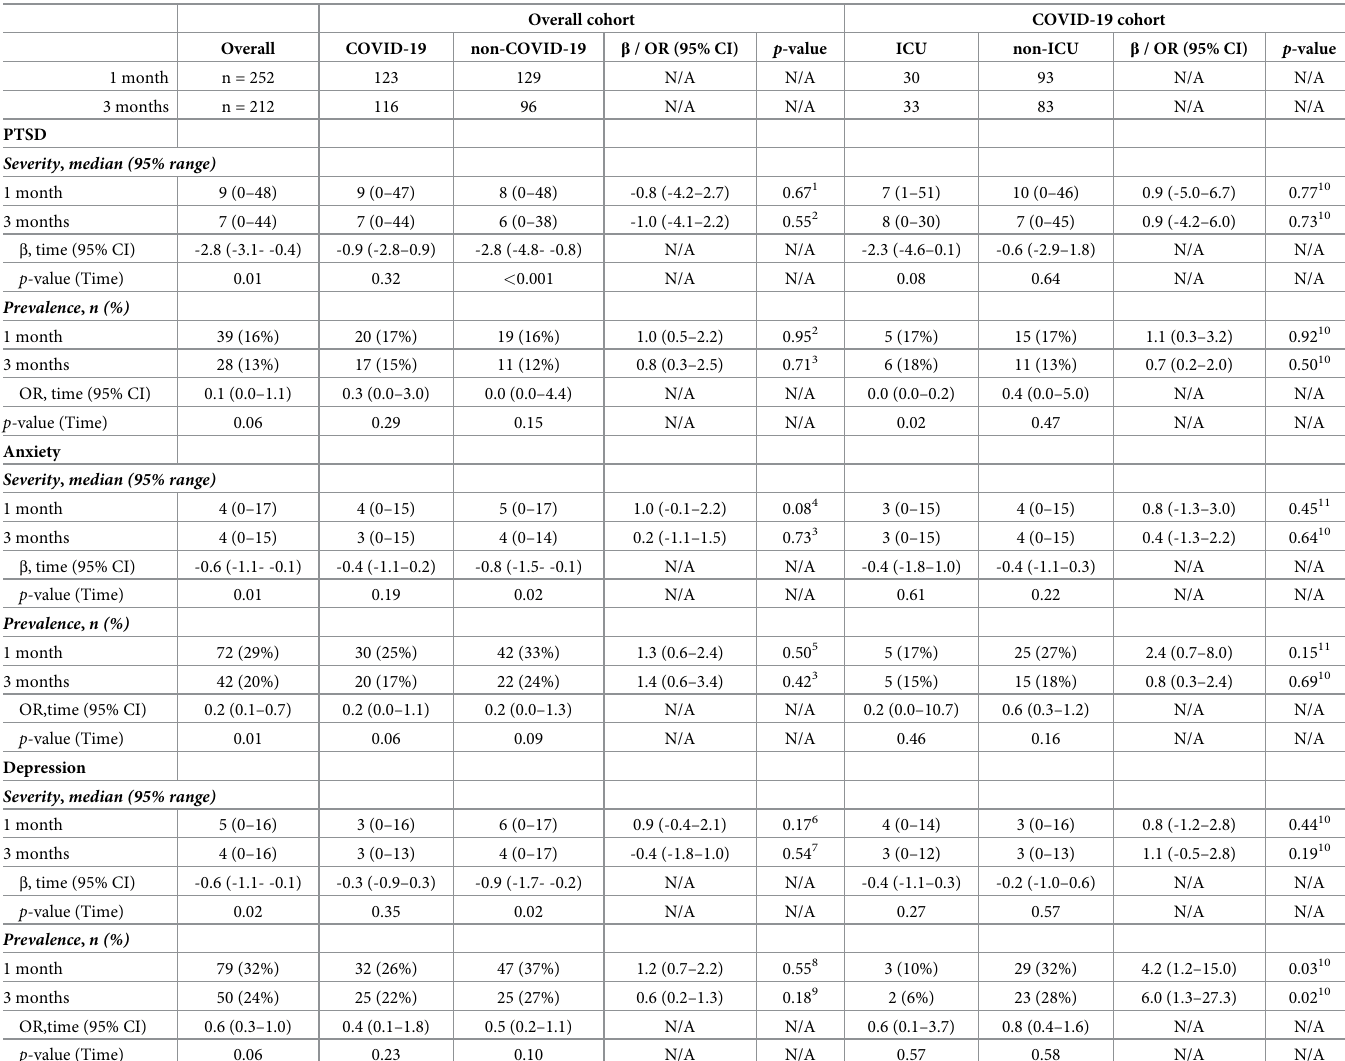
Table 2. Psychological outcomes throughout